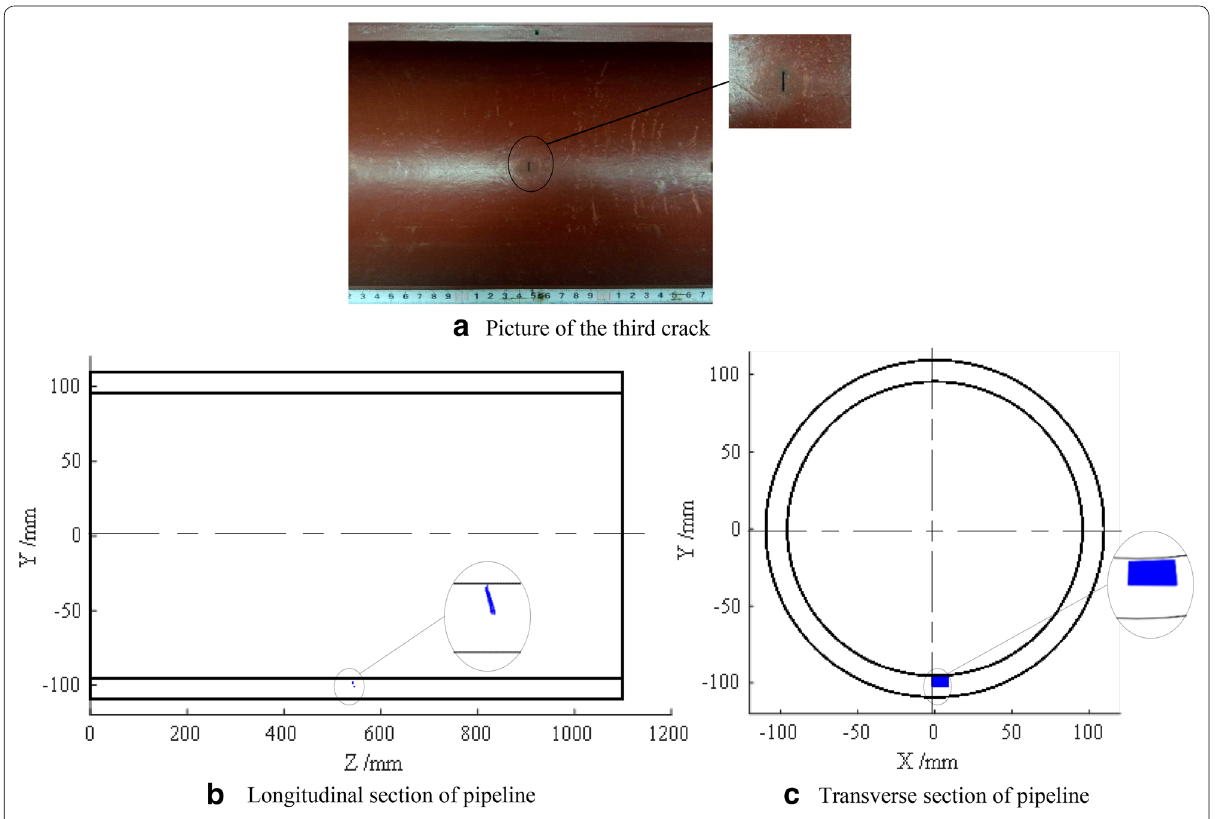
Figure 11 Ultrasound images of the third